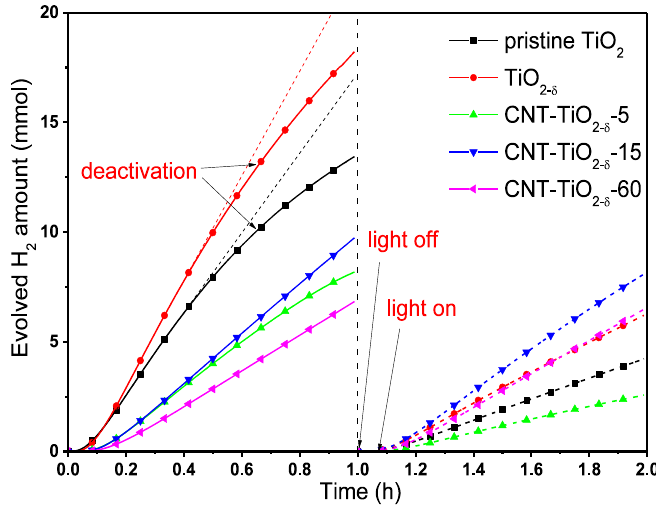
Figure 4. Evolved H 2 amount as a function of reaction time for different photocatalysts in photocatalytic hydrogen production. The reactions were carried out in aqueous methanol solutions (50 mL methanol in 500 mL pure water) using 0.2 g catalyst (pristine TiO 2 , TiO 2−δ or CNT-TiO 2−δ composites). Before the reaction, 0.1 wt% Pt was photodeposited